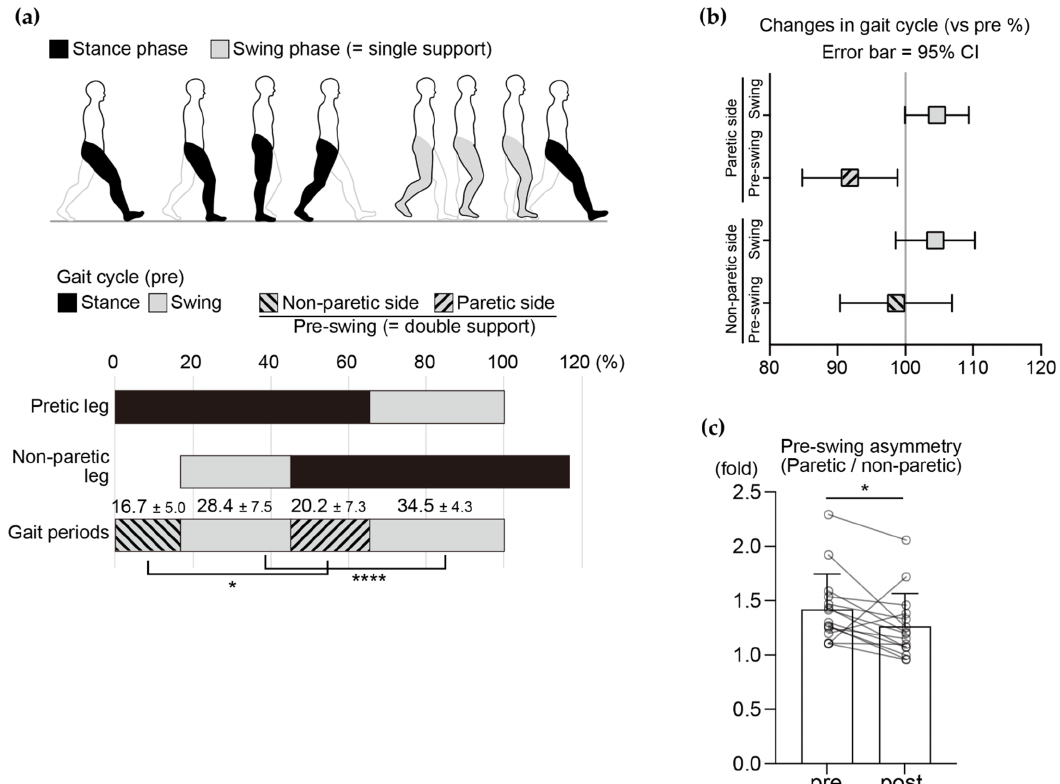
Figure 3. Proportion of gait cycle prior to the intervention and changes in gait cycle after the intervention. ( a ) Illustration shows the gait cycle (stance phase and swing phase). The pre-swing phase (double support phase) is the time spent with both feet in contact with the floor. The graph shows the pre-intervention gait cycle (mean ± SD, * p < 0.05, **** p < 0.0001, n = 25). ( b ) Percent change in gait phase after the intervention. * p < 0.05, n.s. not significant; Error bar = 95%; confidence interval, n = 25. ( c ) Fold change in pre-swing asymmetry (paretic/non-paretic) in a subgroup with >1.1-fold asymmetry at the baseline (pre-intervention). The connected plots show the pre- and post-intervention data of a subject. Bar graphs show the mean value. * p < 0.05, error bar = SD, n = 15.